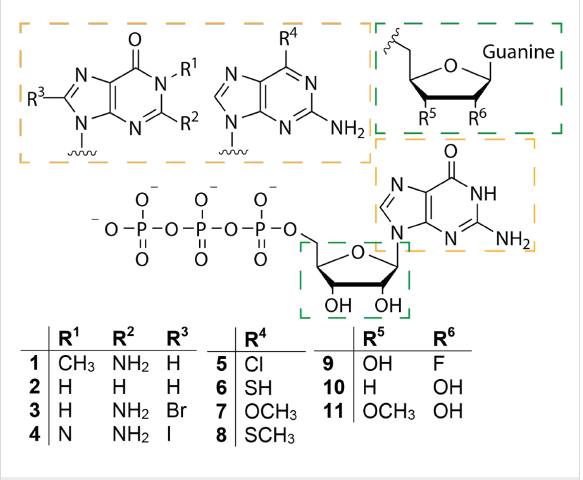
Figure 2: Nucleotide analogues 1 – 11 were converted by Paramecium bursaria Chlorella virus-1 capping enzyme instead of GTP to generate RNAs with the respective caps